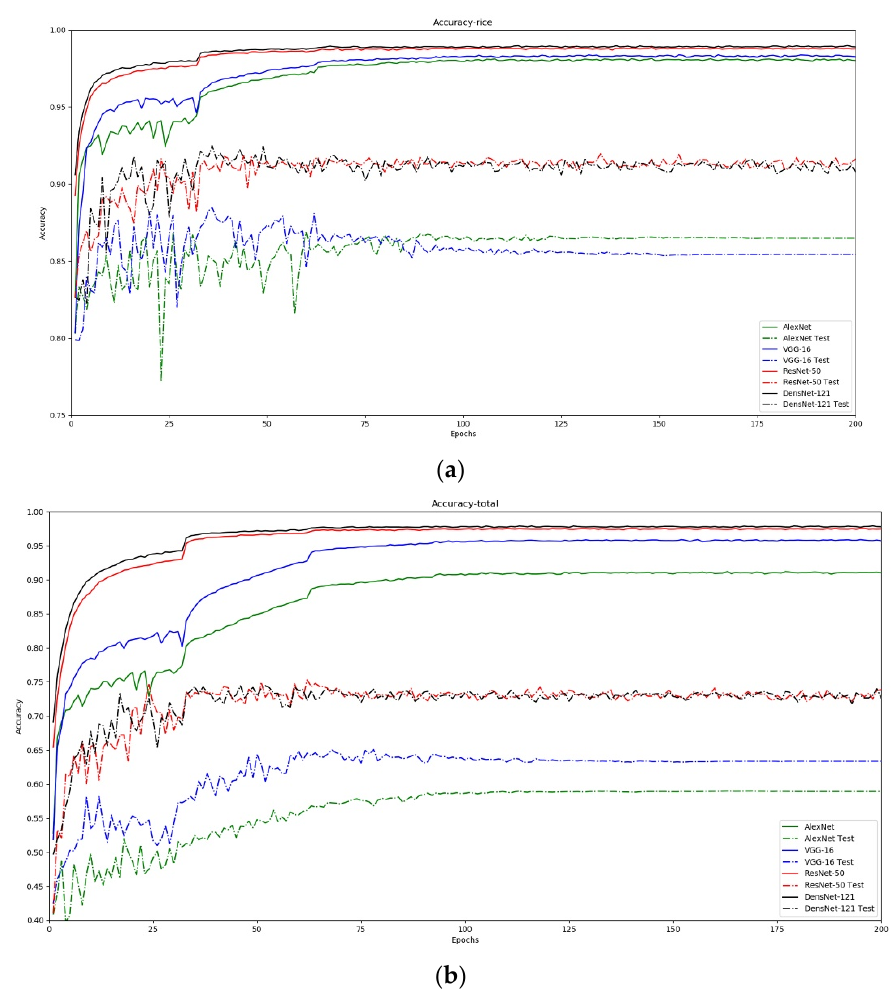
Figure 10. The test results of the accuracy for the binary classification and eight classification experiments. ( a ) The accuracy of rice and non-rice classification and ( b ) the accuracy of eight classifications of the different phenological stages. Table 6. The accuracy of fine classification by using four networks.